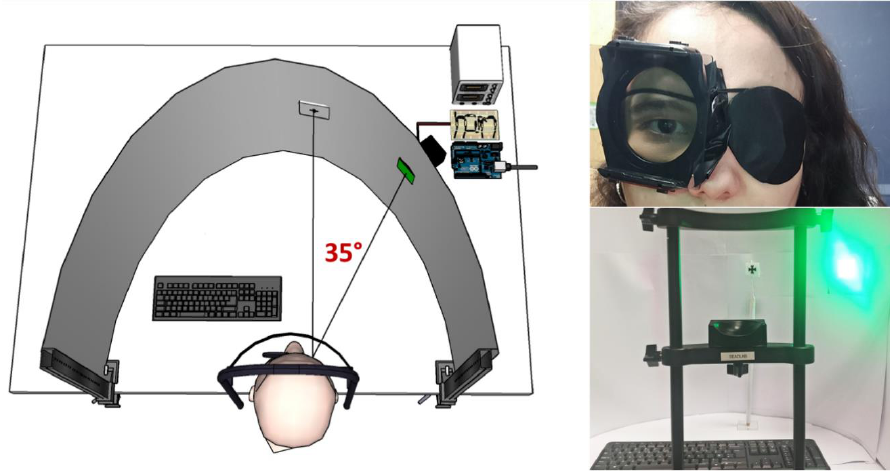
Figure 1. Graphical representation and photos of the experimental setup.